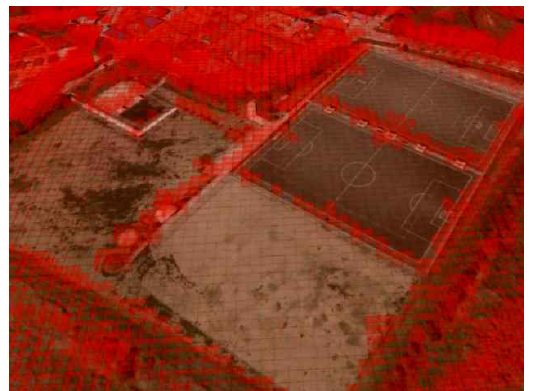
Figure 8. Generated 3D UAV obstacle grid overlaid on an